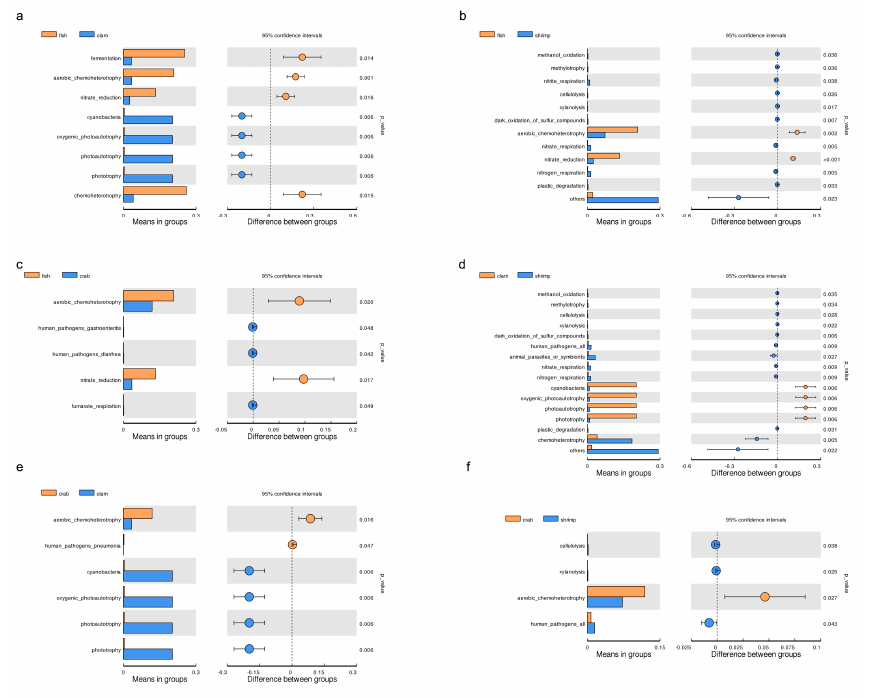
Figure 5. Significant differences ( t –tests) were observed for microbial functions in the intestines of aquatic animals. ( a ) fish vs. clam; ( b ) fish vs. shrimp; ( c ) fish vs. crab; ( d ) clam vs. shrimp; ( e ) crab vs. clam; ( f ) crab vs. shrimp.